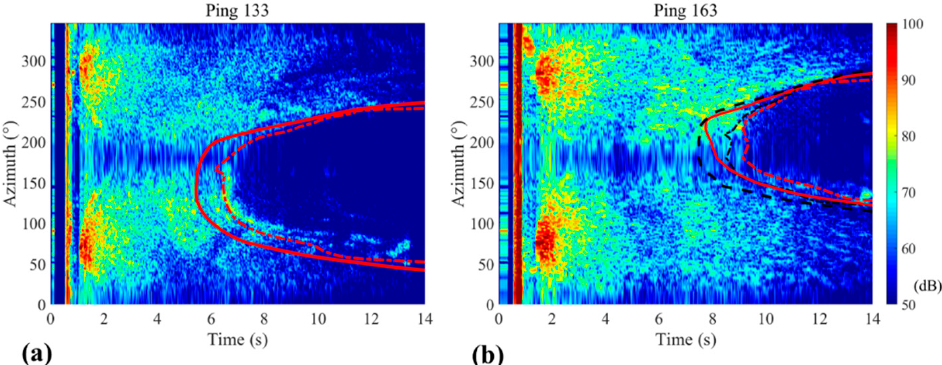
Figure 16. Comparison of measured BTRs and two-way MDP travel time+ curves computed by the depth-bistatic model using the KorBathy 30s (red dash-dotted line) and the GEBCO 2020 (red solid line): ( a ) ping 133 and ( b ) ping 163. In ( b ), the black dash-dotted and black dashed lines represent the results of full bistatic modeling using the KorBathy 30s and the GEBCO 2020, respectively.